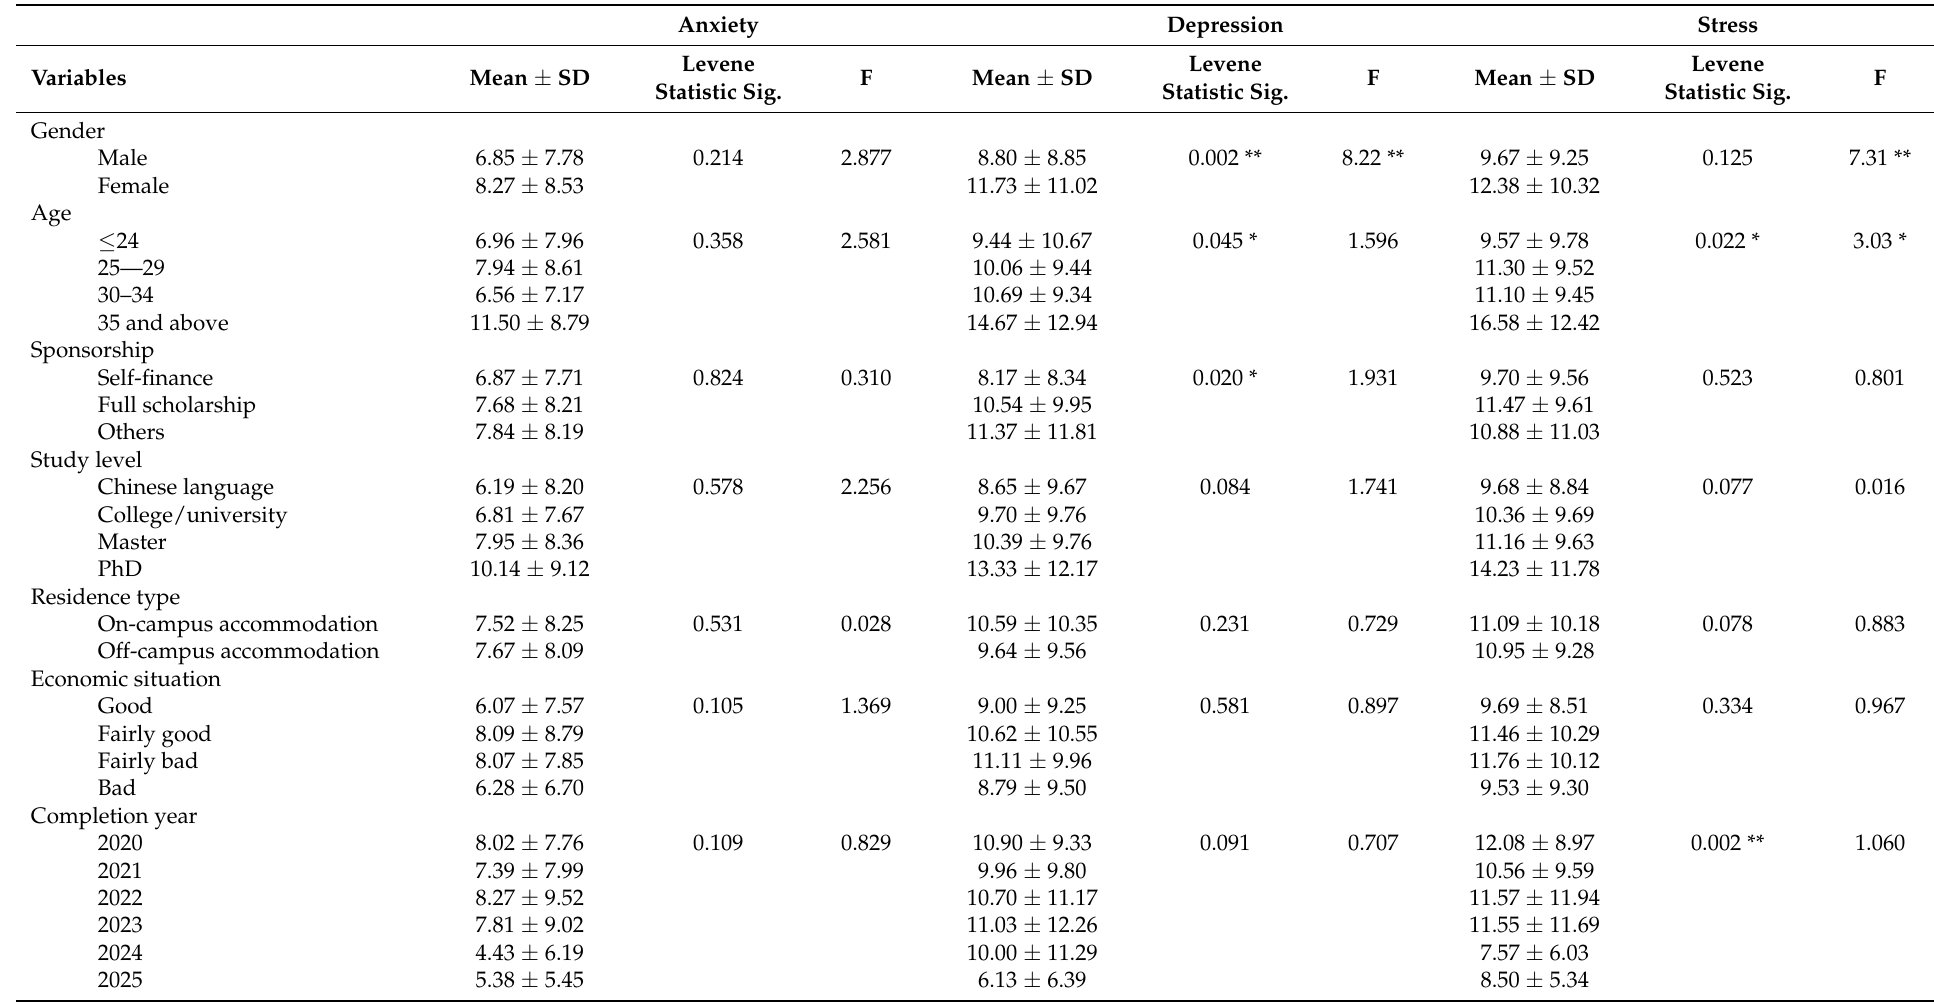
Table 2. One-way ANOVA analysis